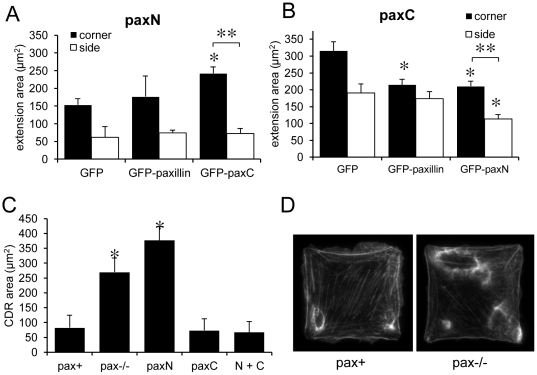
PaxN and paxC exert complementary effects on lamellipodia formation, and co-expression of the separate halves of paxillin can rescue both corner lamellipodia formation and suppression of CDRs and side membrane extension.A) GFP, GFP-paxillin, or GFP-paxC were transiently expressed in paxN MEFs plated on 50×50 µm FN islands, stimulated with PDGF (25 ng/ml) for 30 min, fixed and stained to label F-actin. Expression of GFP-paxC, but not GFP alone or GFP-paxillin, could rescue enhancement of corner lamellipodia formation. B) GFP, GFP-paxillin, or GFP-paxN were transiently expressed in paxC MEFs as in A. Expression of GFP-paxillin and GFP-paxN suppressed corner extension area, but only expression of GFP-paxN also suppressed side extension area. n>15 cells per genotype. * p<0.01 compared to GFP alone. ** p<0.001 between corner and side extension areas. C) Quantification of CDR area in square cells stimulated with PDGF for 5 min shows that paxC rescues CDR suppression when expressed in either pax−/− or paxN cells. * p<0.01 compared to pax+. D) Pax+ and pax−/− cells fixed at 5 min and stained to label for F-actin to visualize CDRs.